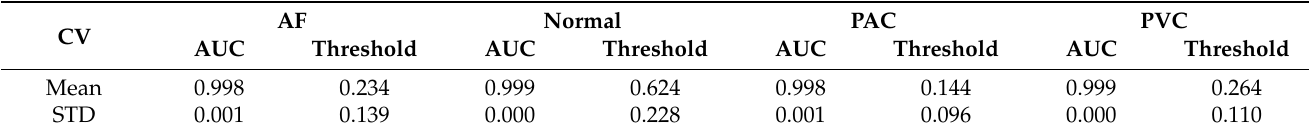
Table 12. Performance of the second stage cross-validation test using the AUC of the ROC curve.